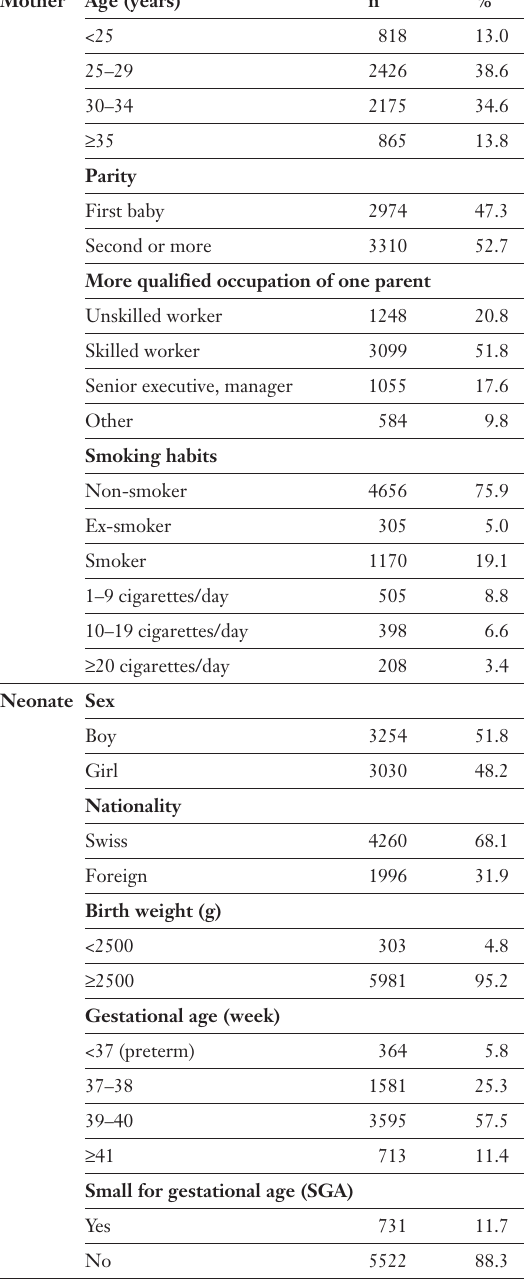
Table 1 Characteristics of mothers and neonates (n = 6284).